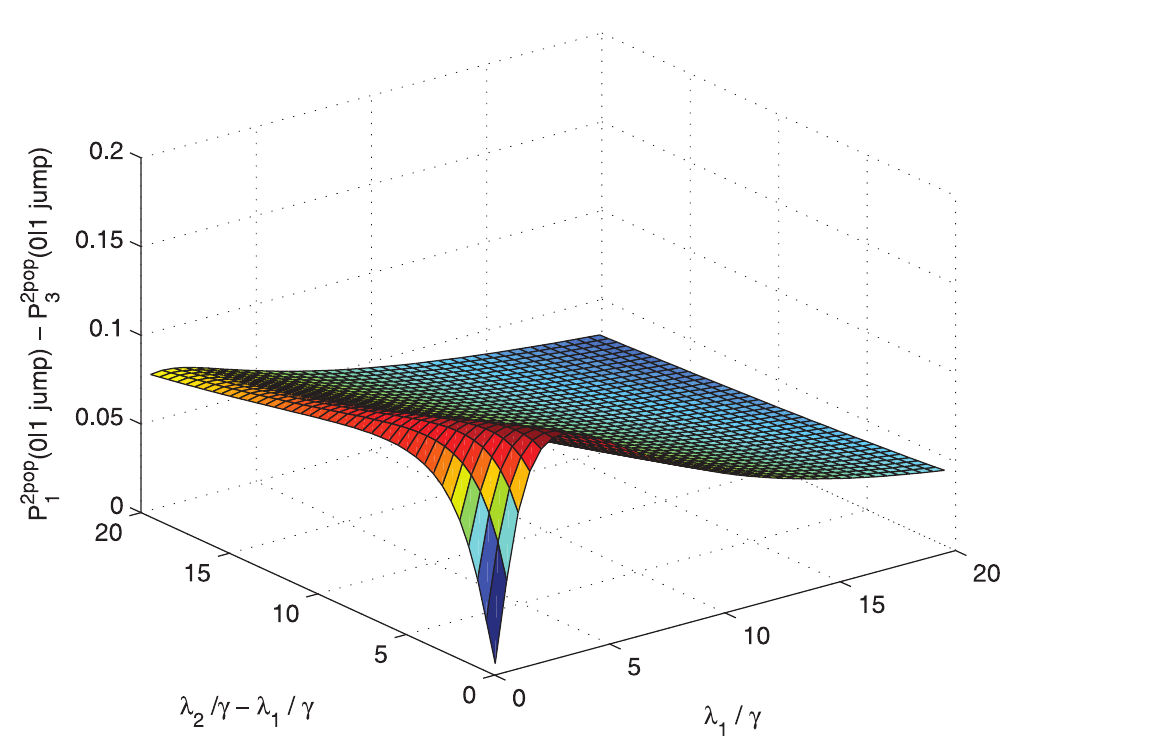
Figure 2. Comparison of probabilities of no secondary cases in a two-population model where individuals move only once. Variation of P 2 pop (0 D 1) { P 2 pop (0 D 1) is represented as a function of l 2 = c and l 1 = c which vary on plausible ranges of values, under the constraint l 2 = c § l 1 = c . All 1 3 parameters and variables are explained in Table 1.